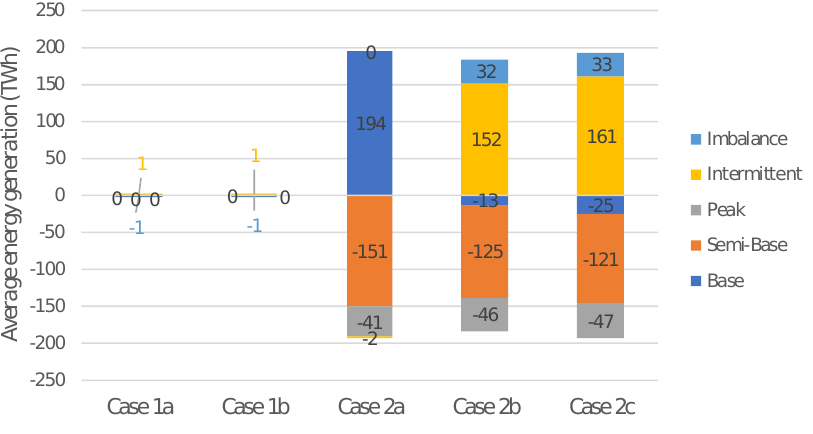
Figure 13. Comparison of energy generation breakdown between cases relative to the base case (Case 0).